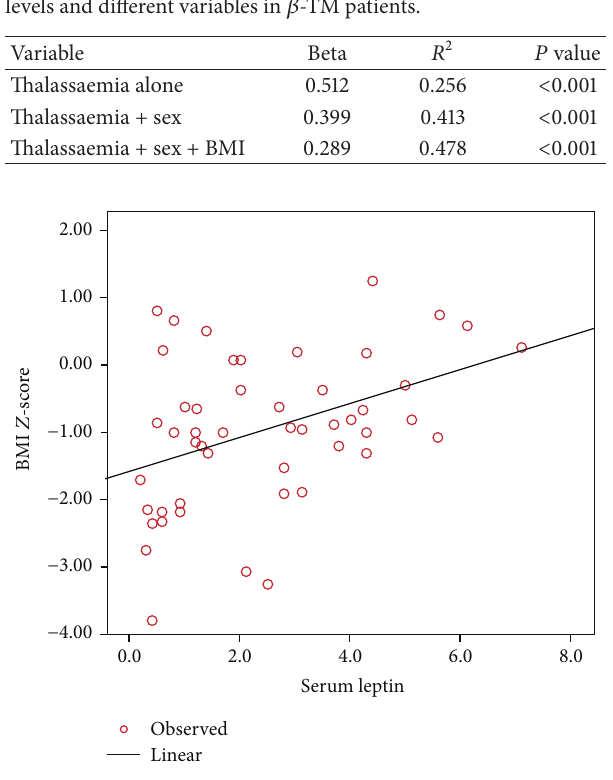
Figure 2: Correlation between serum leptin levels (ng/mL) and the BMI 𝑍 -score in 𝛽 -TM patients. Pearson correlation coefficient ( 𝑟 = 0.404 , 𝑃 = 0.004 ).